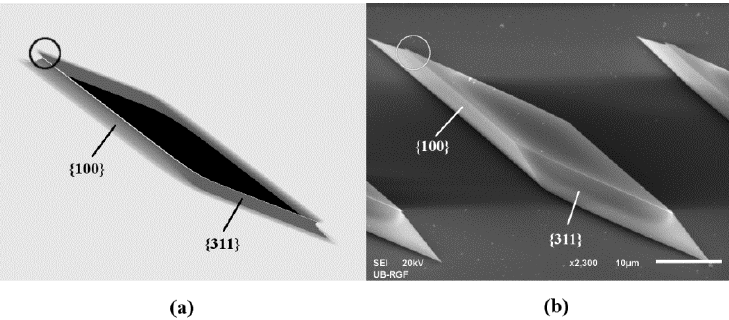
Figure 6. Enlarged 3D silicon shape from Figure 5. The angles of tiltation are 30 ◦ . The appearances of the planes directly under the masking layers, which have smaller surfaces than the dominant ones and form shapes resembling ship prows, are marked with circles. ( a ) Simulated etching profile; ( b ) SEM micrograph.